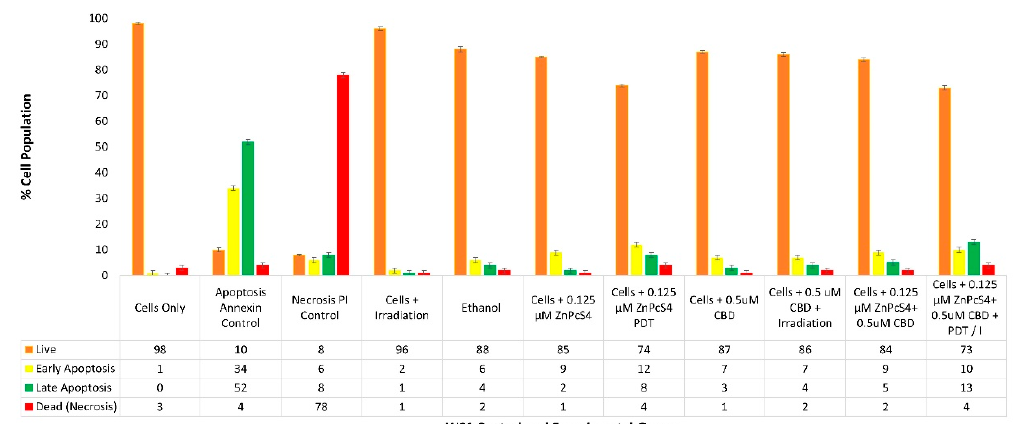
Figure 6. Percentage of different stages of cell death using the flow cytometry Annexin V-FITC/PI staining method on various WS1 normal fibroblast control and experimental groups, within ZnPcS 4 PS and CBD PDT/irradiation combinative assays.